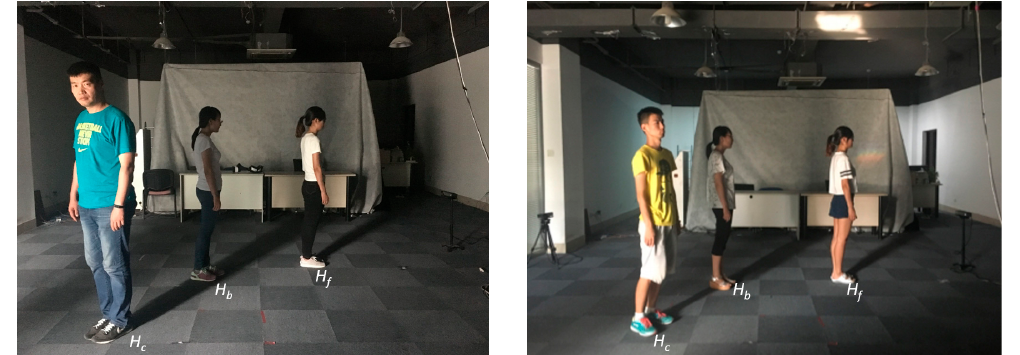
Figure 19. A special case of the occluded person H b